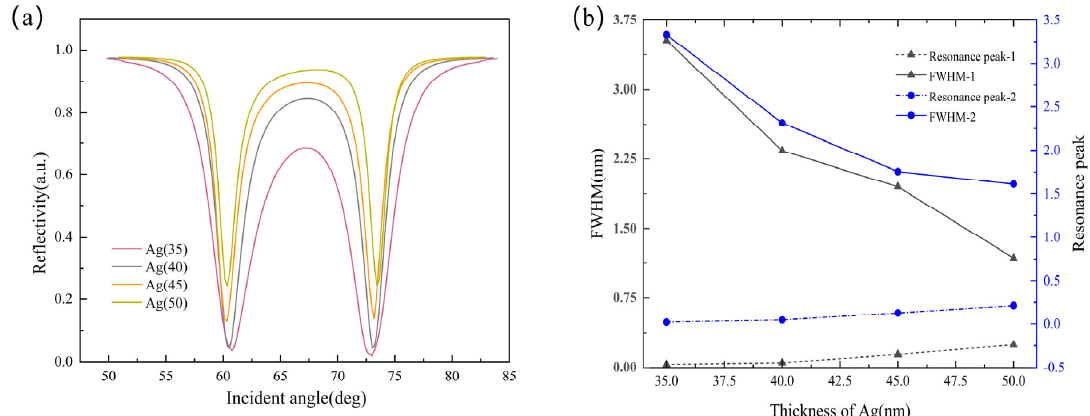
Figure 3. ( a ) Reflectance versus angle curve for different metal thicknesses; ( b ) variations in the half-height width and reflectivity minimum with the thickness of the silver (Ag) layer.